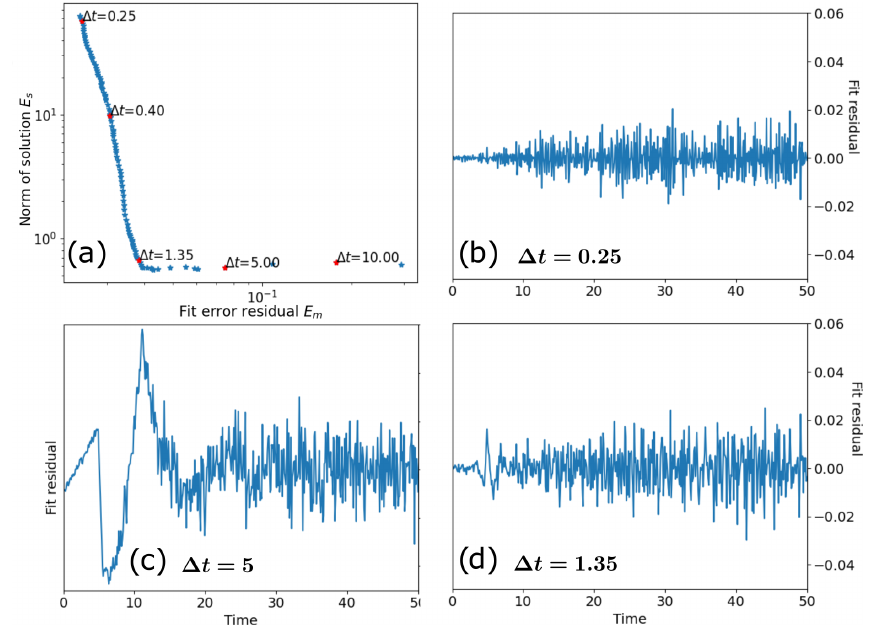
Figure 2. (a) L curve for sweep of different (cid:49)t values for estimated property (RT correction) of simulated measurements given by m j = u m (t j ) + ξ j . On the y axis, E s is the noise in the data given by the step difference between adjacent data points, which is high for models that are too complex (lower (cid:49)t/ higher number of data points) in the model. The x axis is the fit error residual E m , which shows how well the results (the u a s) explain the measurements m . The latter is high for too sparse models (high (cid:49)t/ low number of data points). Panels (b) , ) − m j for each point in measurement time using (cid:49)t = 0 . 25 (b) , (cid:49)t = 5 (c) , and (cid:49)t = 1 . (c) , and (d) show fit residuals ˆ u(t (cid:48) j